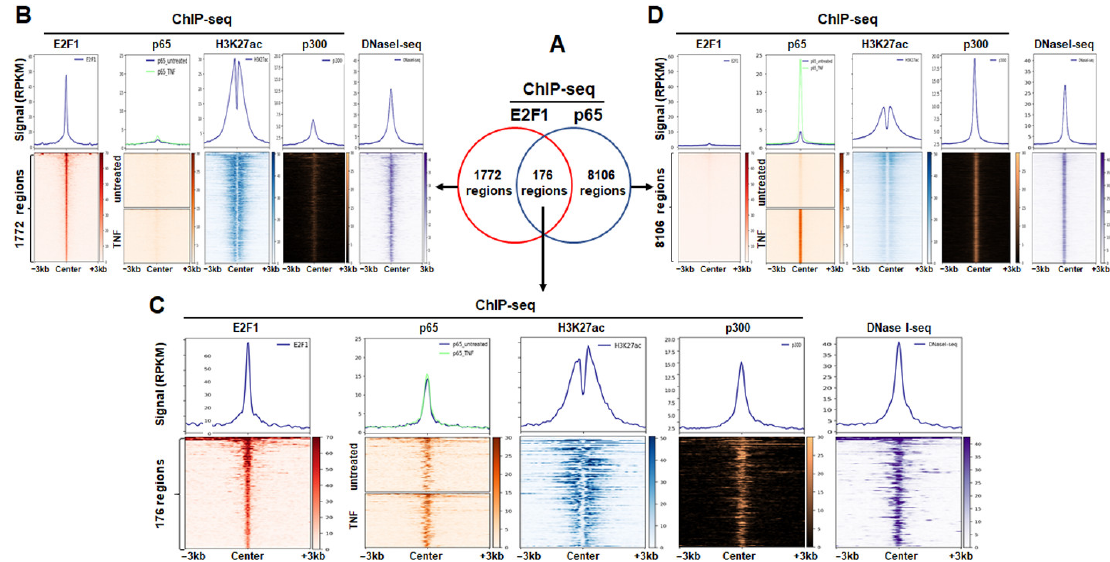
Figure 1. ( A ) Venn plots depicting the common E2F1-p65, the E2F1-specific, and the p65-specific binding regions (cistromes) in HeLa cancer cells. ( B – D ) Aggregate plots ( up ) and heatmaps ( down ) illustrating the signal distribution for E2F1, p65, H3K27ac, and DNaseI-seq accessibility around the E2F1-specific, the common E2F1-p65, and the p65-specific binding regions, respectively.